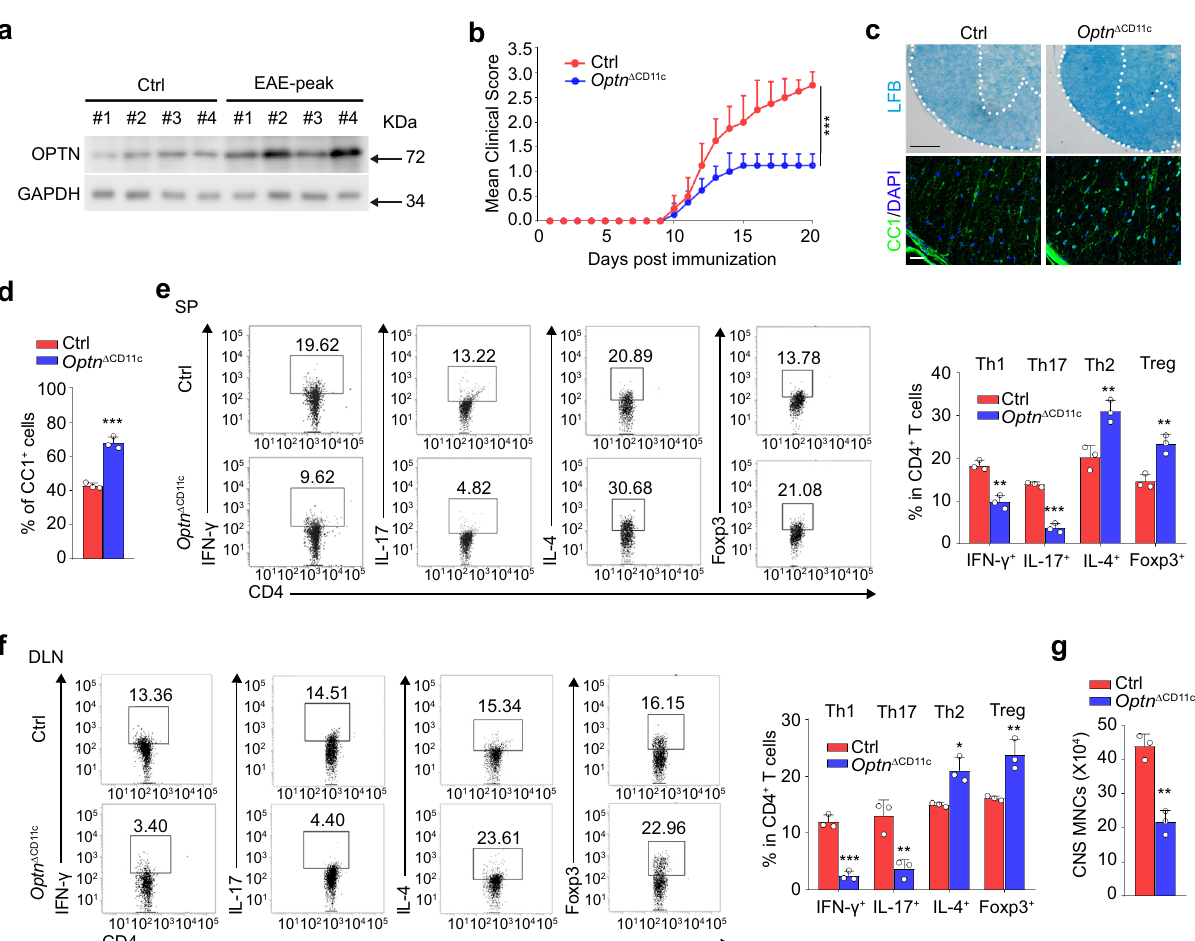
Fig. 3 Optn de fi cient mice are resistant to EAE pathogenesis and in fl ammation. a Western blotting analysis for the expression of OPTN in the BMDCs from four pairs of C57BL/6 Ctrl and EAE mice (8-week-old, female) at day 20 after immunization. n = 3 independent experiments. b Mean clinical scores of Ctrl and Optn Δ CD11c mice (8-week-old, female) subjected to MOG 35 – 55 -induced EAE. n = 8 independent animals, P = 3.3E − 09. c (Upper) Luxolfast blue (LFB) staining of mouse spinal cords from Ctrl and Optn Δ CD11c EAE mice at day 20 post immunization (dpi 20). Scale bars, 200 μ m. (Lower) Immuno fl uorescent labeling of CC1 (green) and DAPI (blue) in the spinal cord of indicated mice at day 20 after immunization. Scale bars, 20 μ m. n = 3 independent animals. d The summary graphs of CC1 + cells in ( c ). n = 3 independent animals, P = 0.0004. e , f Frequency of Th1, Th17, Th2, and